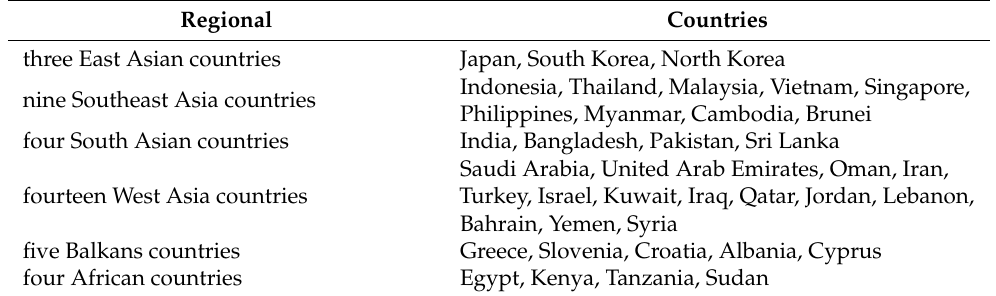
Table 1. MSRCs and regional